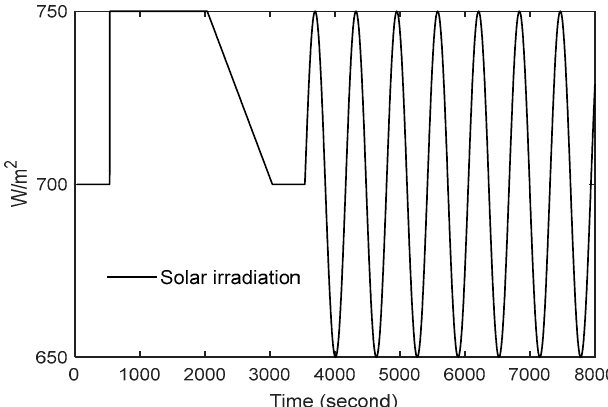
Figure 12. Profile of the step, ramp and sinusoidal disturbance of solar irradiation performance.